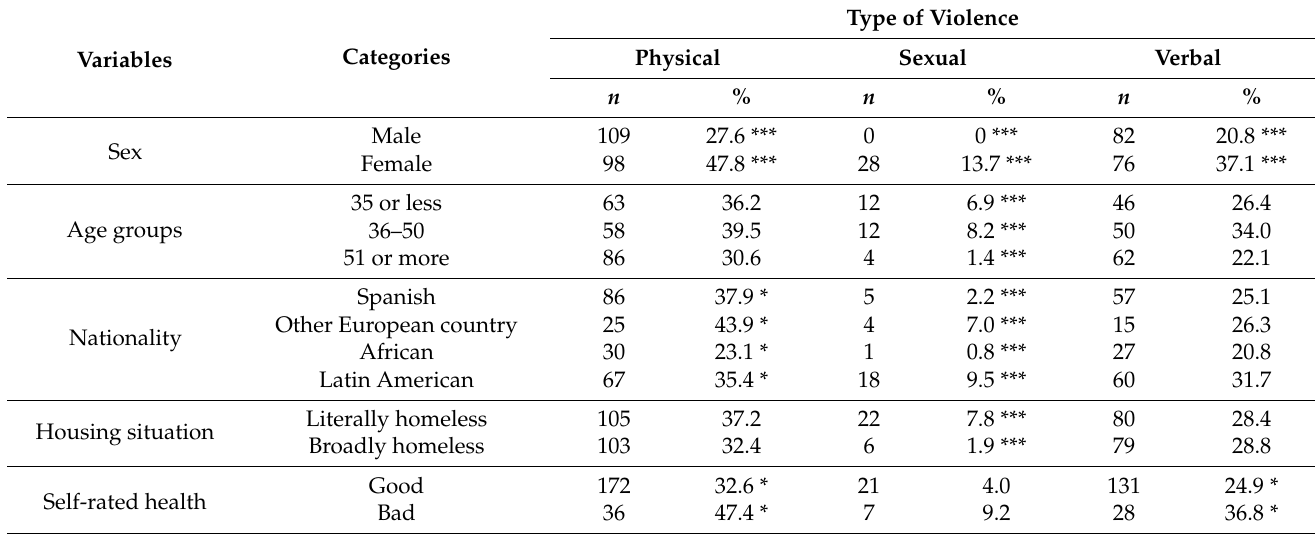
Table 5. Relations found between violence and the study